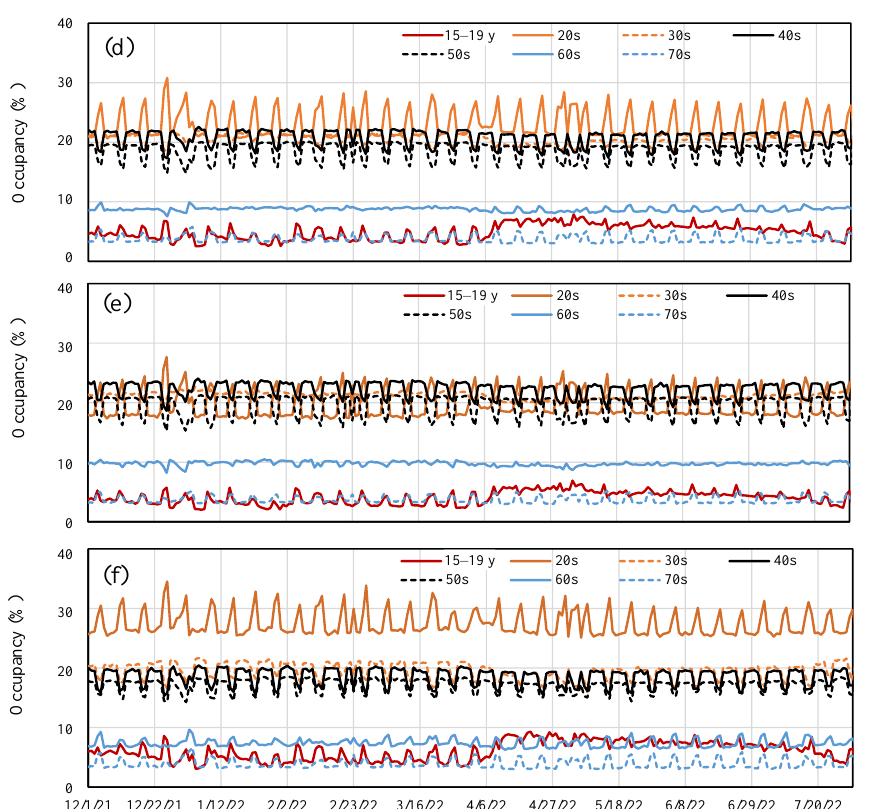
Figure A1. ( a – c ) Time course of the nighttime population by age category and ( d – f ) the occupancy of age category in the mobility at the station. The gender categories are ( a , d ) all, ( b , e ) male, and ( c , f ) female.